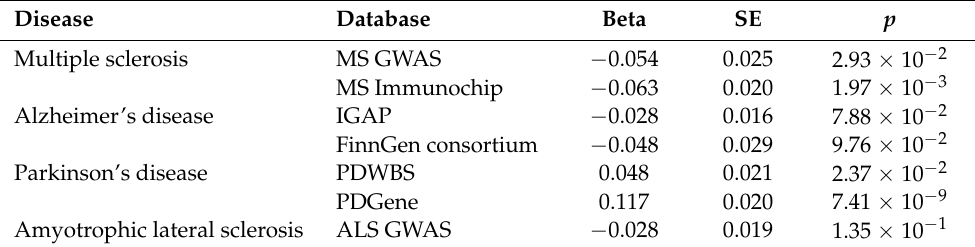
Table 2. Association between rs4988235 variant T allele and neurodegenerative diseases. Beta, regression coefficient; SE, standard error.